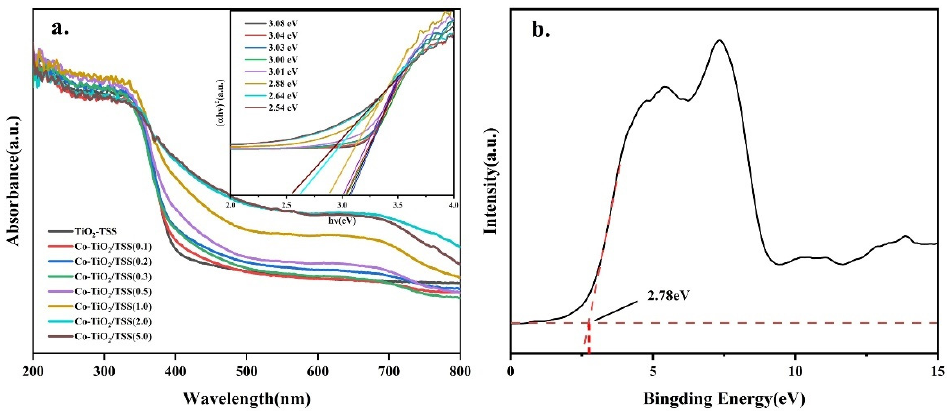
Figure 8. ( a ) UV–vis diffuse reflectance spectra of TiO 2 -TSS and Co-TiO 2 /TSS(X) and Tauc diagram (inset). ( b ) Valence band spectra of Co-TiO 2 /TSS(0.5).